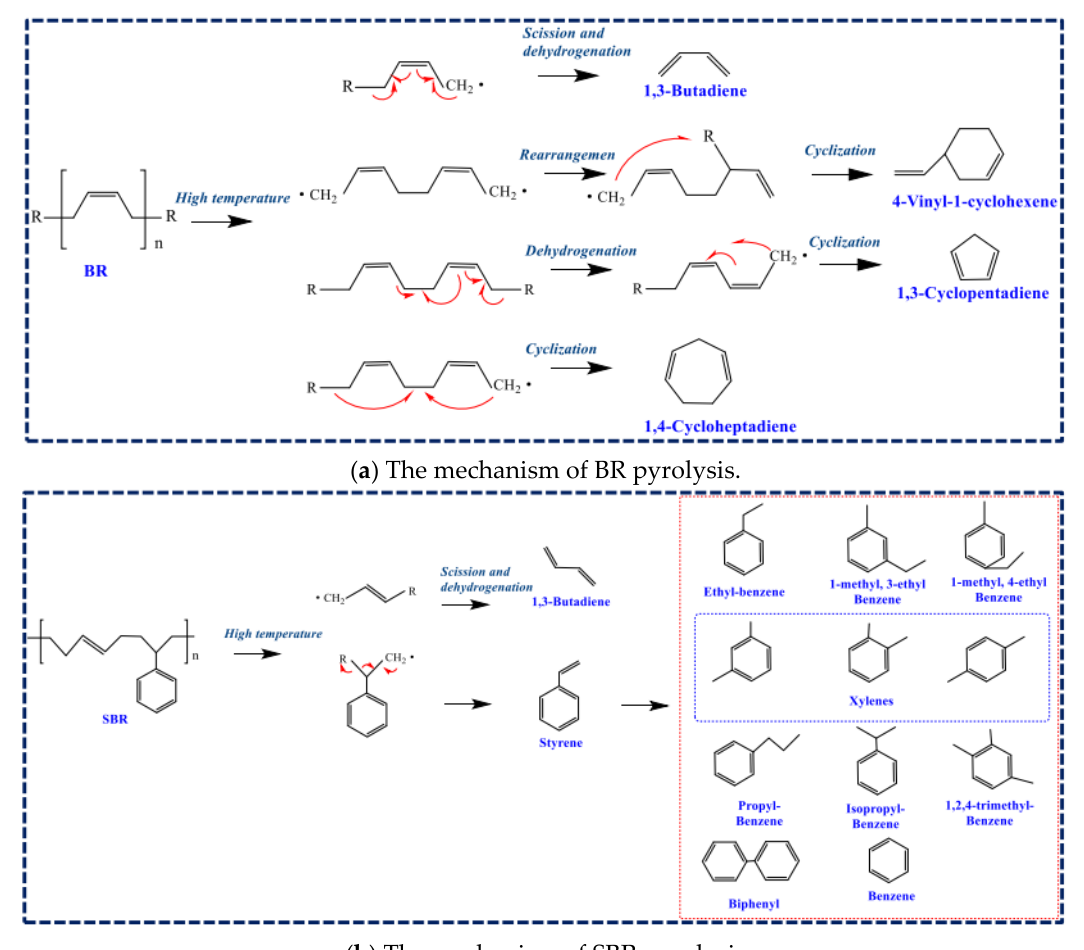
Figure 5. The mechanism of SR pyrolysis; ( a ) BR, ( b ) SBR [29] (adapted with permission from Else-